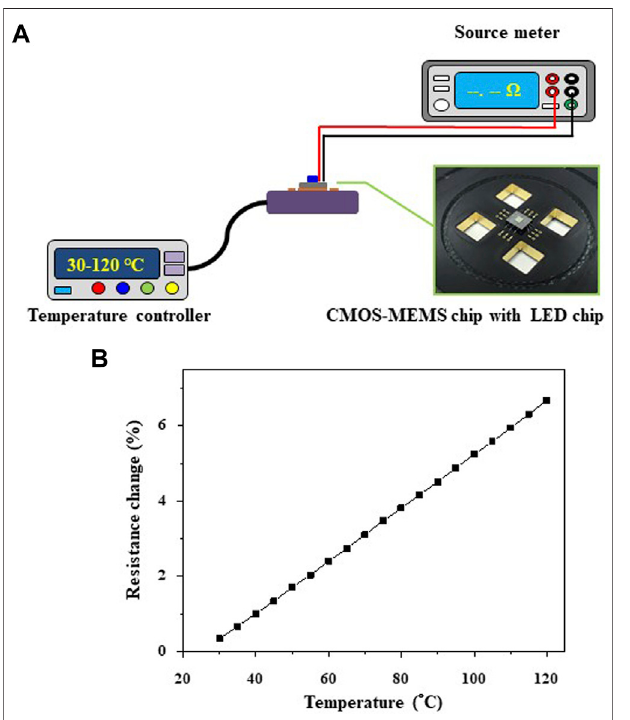
FIGURE 7 | (A) Experimental setup for the calibration of the RTD temperature sensor, and (B) measured resistance change versus temperature.